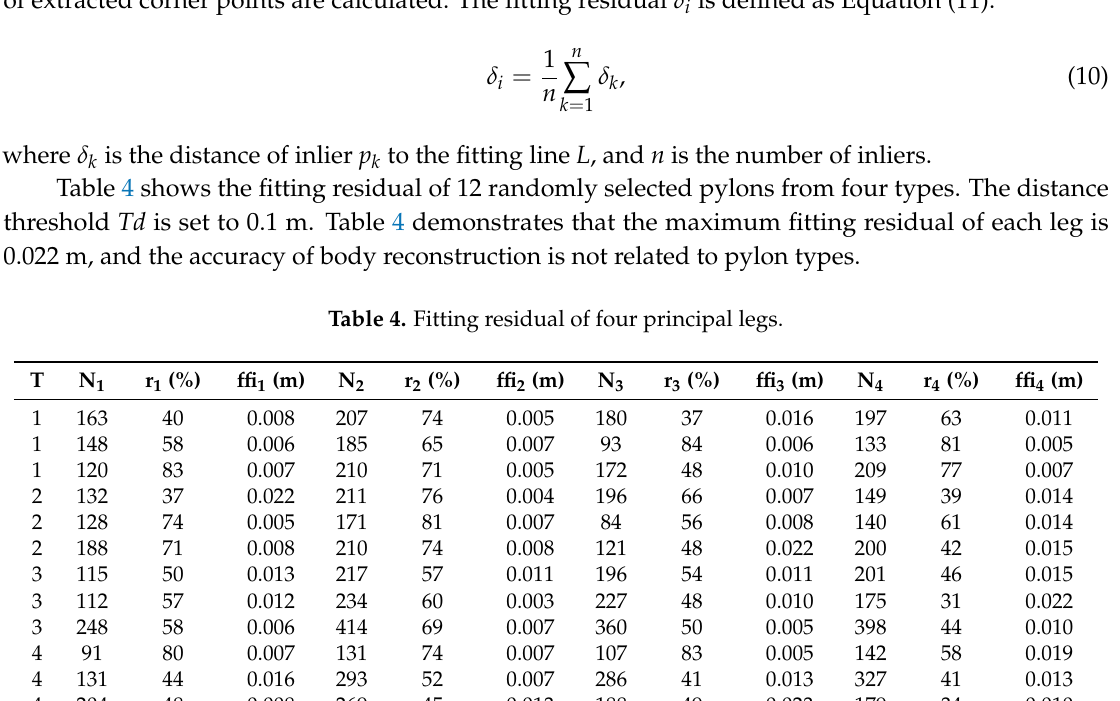
defined as the maximum 2D distance from the pylon points to the four reconstructed legs in the front and side projected plane. The results of the 12 pylon bodies are listed in Table 5. The maximum and average 2D distance to the front plane is 0.153 m and 0.061 m while the maximum and average distance to the side plane is 0.109 m and 0.072 m, and they are sufficiently accurate to meet the requirements of 3D